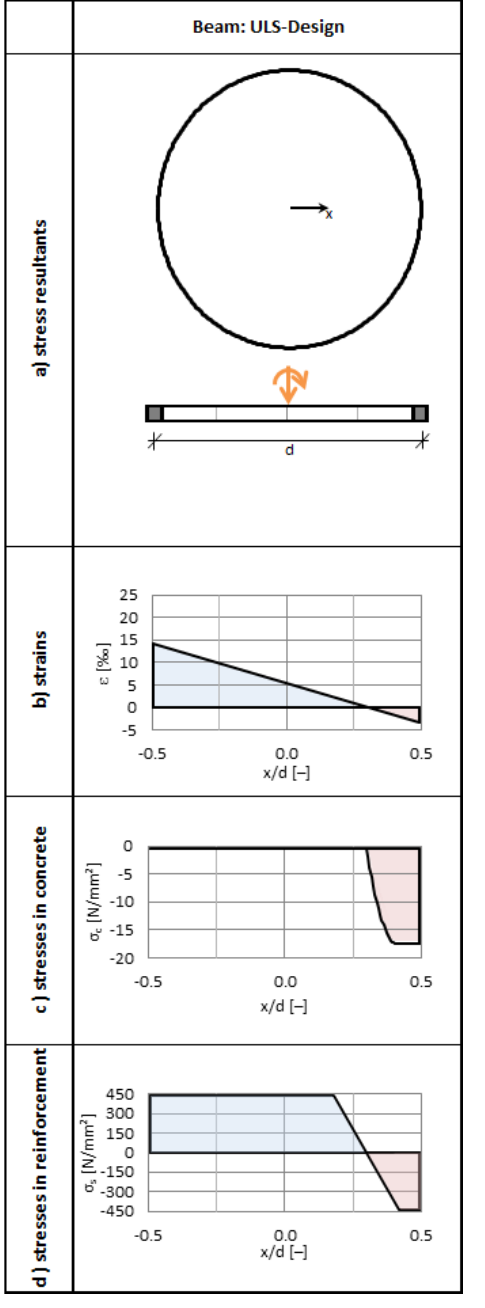
Figure 5. Design via linear elastic shell theory for a specific wind